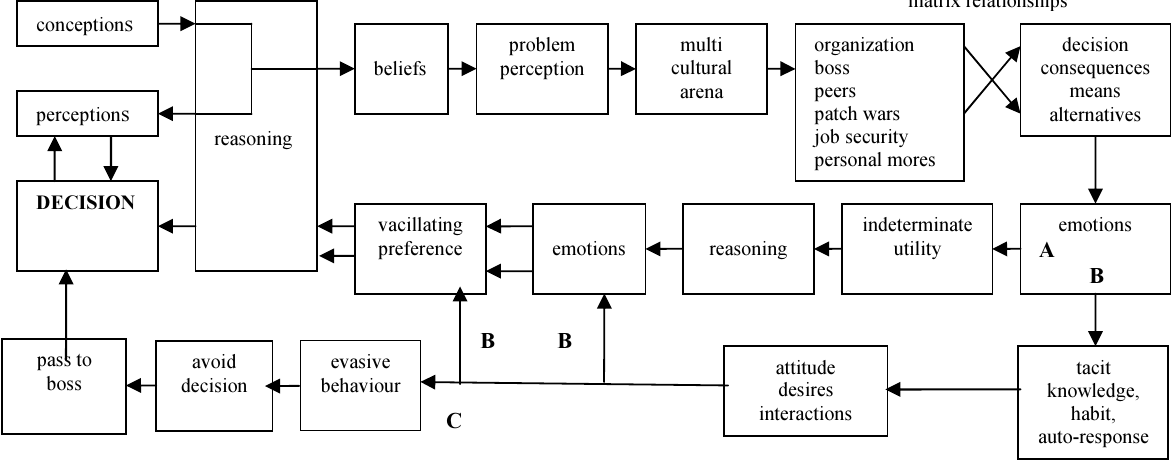
Fig. 3. Complexities in decision making ( adapted from Perugini & Bagozzi 2001; Lindsay & Norman